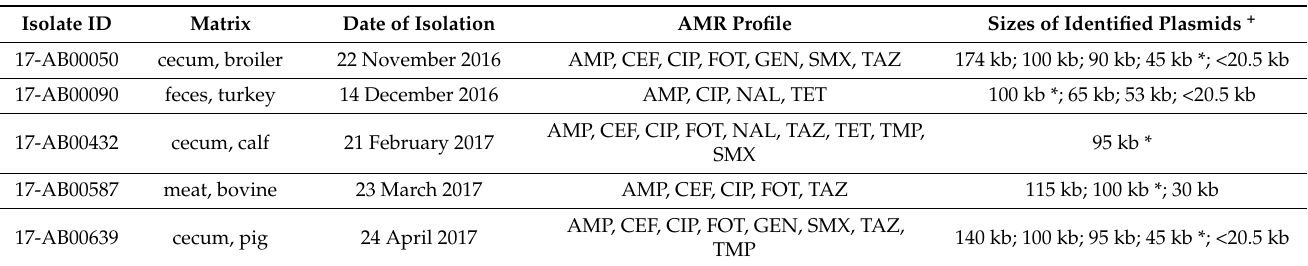
Table 1. Overview on basic information of the E. coli isolates, including their antimicrobial resistance profile and the size of extrachromosomal